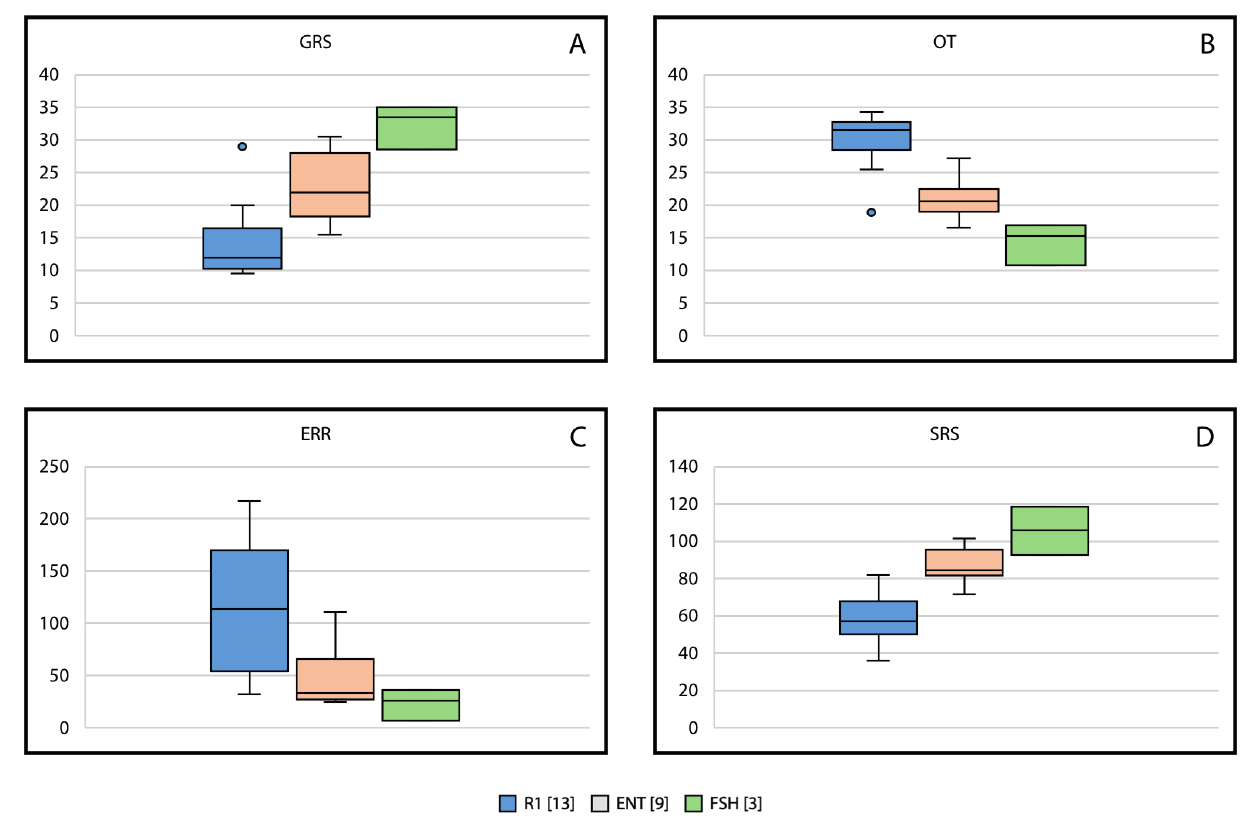
Figure 3. Boxplots showing R1, ENT and FSH performance in terms of GRS (A), OT (B), ERR (C) and SRS (D). Significant differences among groups were found. Brackets: participants per